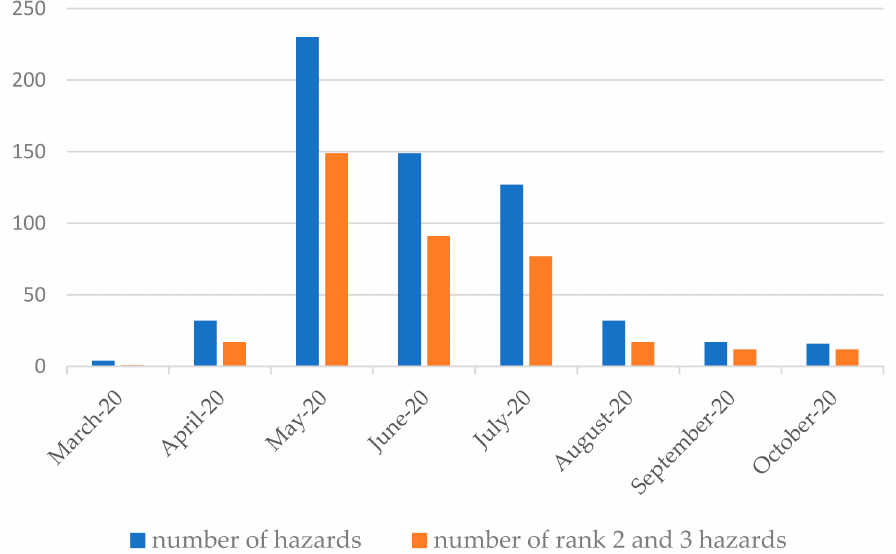
Figure 7. Monthly number of threats associated with the presence of wild boars in the city of Olsztyn. Source: the